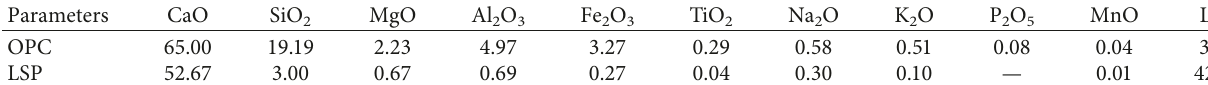
Table 1: Chemical composition of OPC and LSP (%).